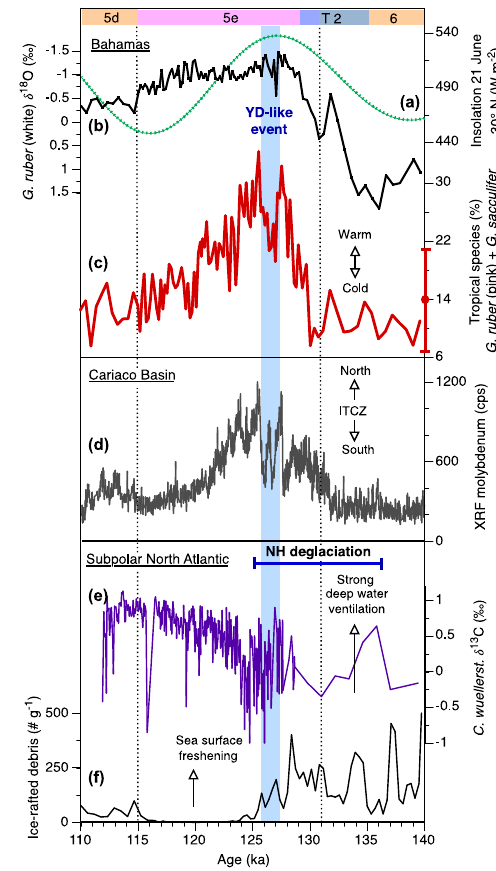
Figure 6. Comparison of proxy records from the tropical, subtrop- ical and subpolar North Atlantic over the last interglacial cycle. (b) δ 18 O values in G. ruber (white) in core MD99-2202 (Lantzsch et al., 2007). (c) Relative abundances of the tropical species G. sac- culifer and G. ruber (pink) in core MD99-2202. (d) The molyb- denum record from ODP Site 1002 (Gibson and Peterson, 2014). (e) δ 13 C values measured in benthic foraminifera from core MD03- 2664 (Galaasen et al., 2014, age model is from Zhuravleva et al., 2017b). (f) Ice-rafted debris in core PS1243 (Bauch et al., 2012, age model is from Zhuravleva et al., 2017b). Also shown is (a) boreal summer insolation (21 June, 30 ◦ N), computed with AnalySeries 2.0.8 (Paillard et al., 1996) using Laskar et al. (2004) data. Shown in (c) are modern relative abundances of G. sacculifer and G. ru- ber (pink) (average value ± 1 σ ) around Bahama Bank, computed using the seven nearest samples from the Siccha and Kuˇcera (2017) database. The blue band suggests a correlation of events (Younger Dryas-like cooling) across the tropical, subtropical and subpolar North Atlantic (see text). Dashed vertical lines frame MIS 5e. T2 represents Termination